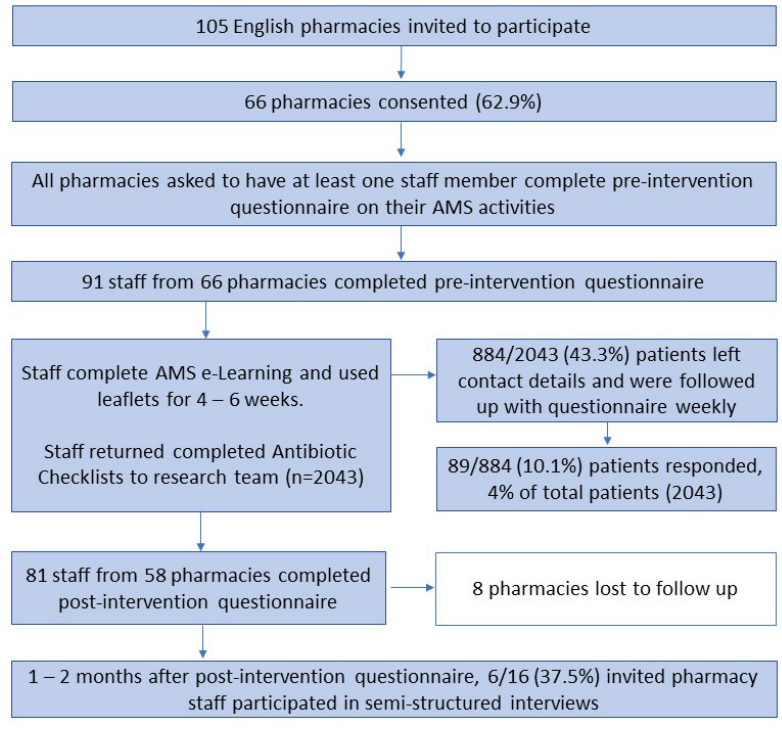
Figure 1. Mixed-method data collection process showing the study progression, methods, and par- ticipants.